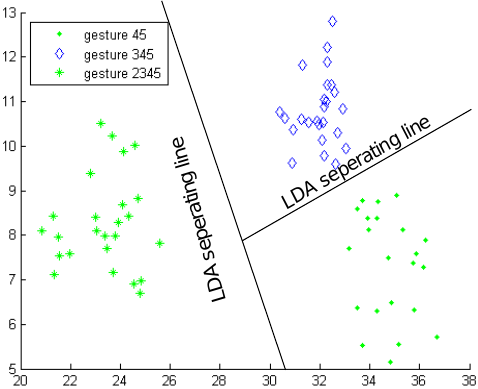
Figure 15. Classifier 6 in the third-level of the first